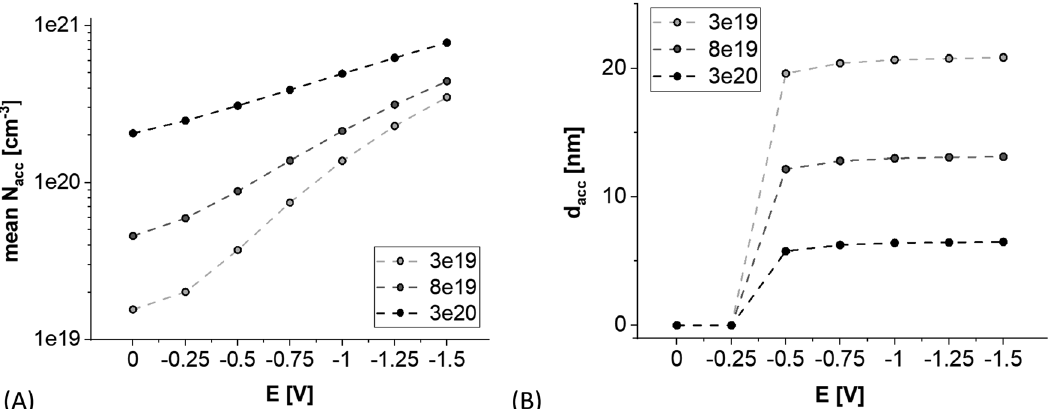
Figure 2: E -induced evolution of accumulation layer where (A) and (B) shows mean charge carrier density and thickness of the layer, respectively, for initial bulk carrier density N reaching 3e19, 8e19, and 3e20 cm − 3